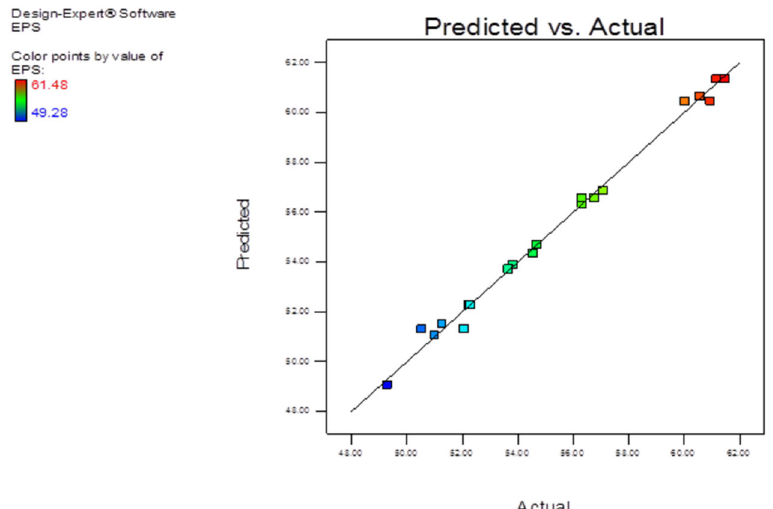
Figure 1. Parity plot: showing the relation between actual and predicted values for pullulan recovery. doi: